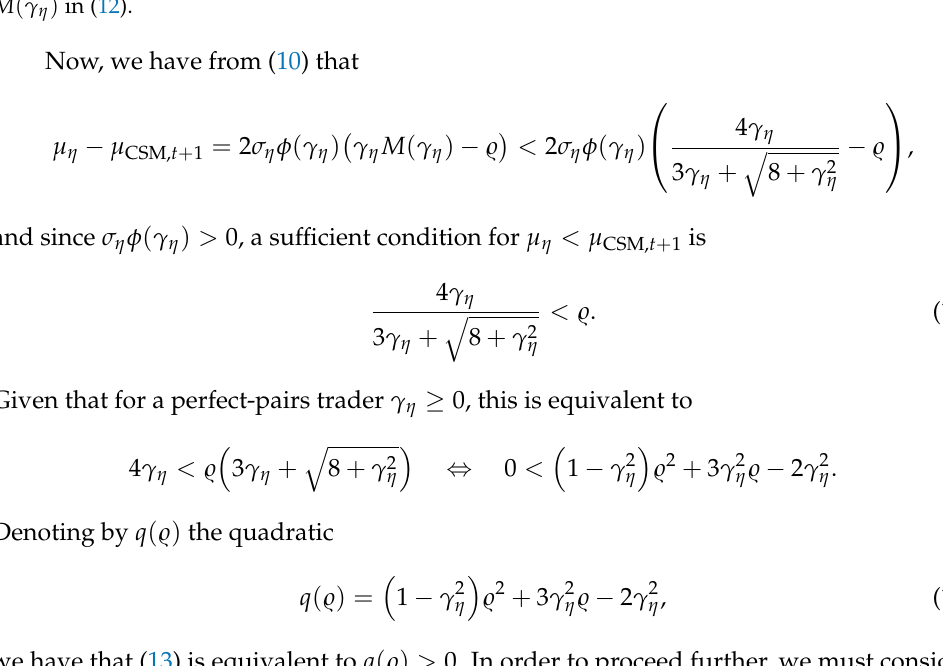
Fig. 1 Plot of γ η M ( γ η ) and γ η U ( γ η ) as functions of γ η , where U ( γ η ) is the upper bound of M ( γ η ) in (12) .